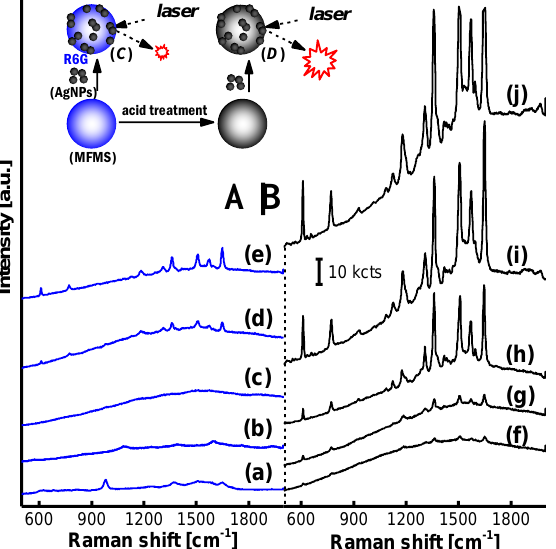
Figure 4. Impact of the acid-treatment reaction on R6G-SERRS spectra on the AgNP/MF n substrate: ( a ) AgNP/MF 1 , ( b ) AgNP/MF 2 , ( c ) AgNP/MF 3 , ( d ) AgNP/MF 6 and ( e ) AgNP/MF 9 in ( A ) were collected on the substrate incorporating non-treated microspheres at a laser power of 0.2 mW; meanwhile ( f ) AgNP/MF 1 , ( g ) AgNP/MF 2 , ( h ) AgNP/MF 3 , ( i ) AgNP/MF 6 and ( j ) AgNP/MF 9 in ( B ) were collected on the substrate incorporating the acid-treated microspheres at a laser power of 0.01 mW. The blank AgNPs was examined at a laser power of 0.05 mW and the R6G-SERRS signal was magnified 3 times as shown at the bottom of ( B ). As shown in the inset, SERRS signals on the substrate had their intensities enhanced if the incorporated MF n microspheres were pretreated in acetic acid solution. Furthermore, superiority of excess formaldehyde in SERRS detection was noticeable as the parameter (n) increased.